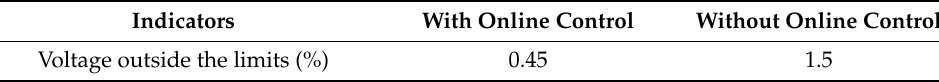
Table 4. Indicators #2. Indicators With Online Control Without Online Control Voltage outside the limits